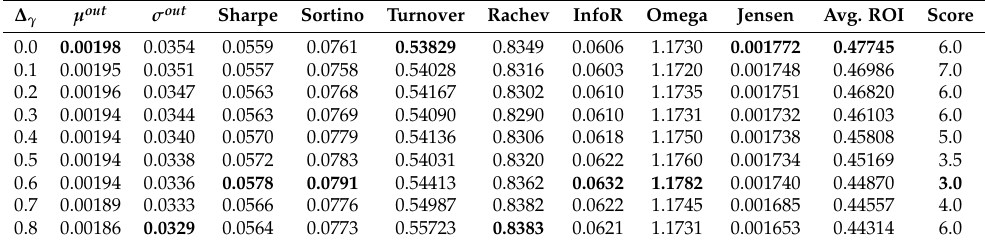
Table 3. ES50: out-of-sample performance results for the KP R strategy by varying ∆ γ .